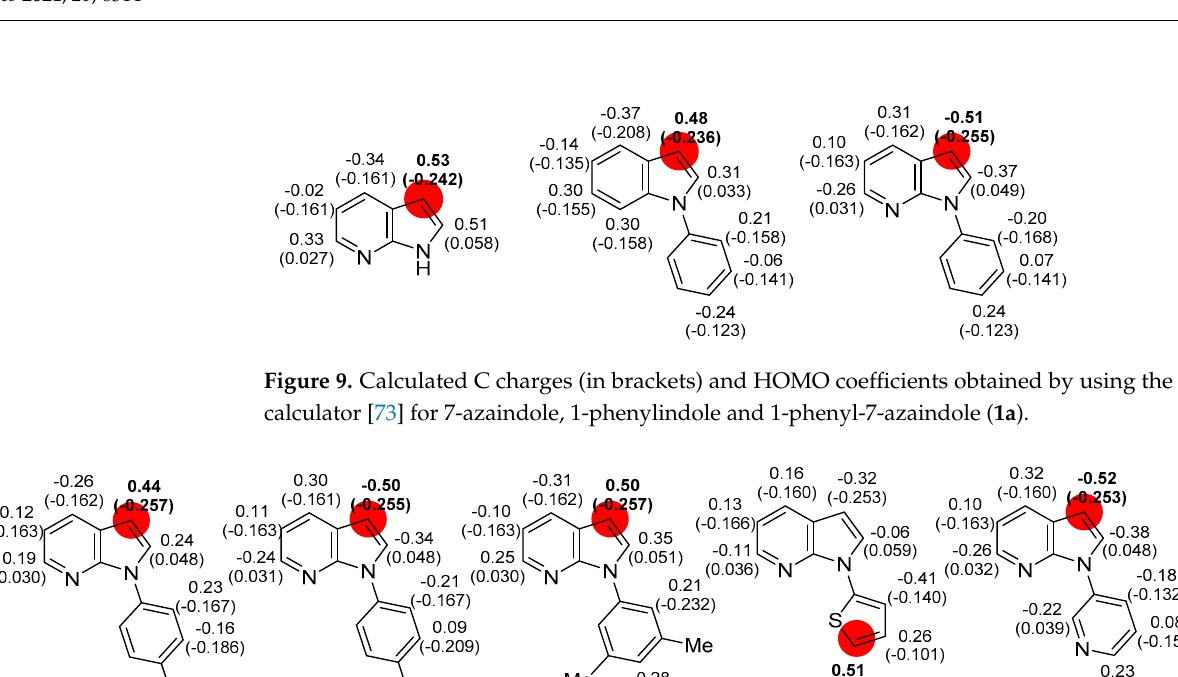
Figure 10. Calculated C charges (in brackets) and HOMO coefficients (obtained by using the HuLiS calculator [73]) for 1-(4-methoxyphenyl)-7-azaindole ( 1b ), 1-(4-fluorophenyl)-7-azaindole ( 1d ), 1-(3,5-dimethylphenyl)-7-azaindole ( 1f ), 1-(2-thienyl)-7-azaindole ( 1g ) and 1-(3-pyridyl)-7-azaindole ( 1h ).